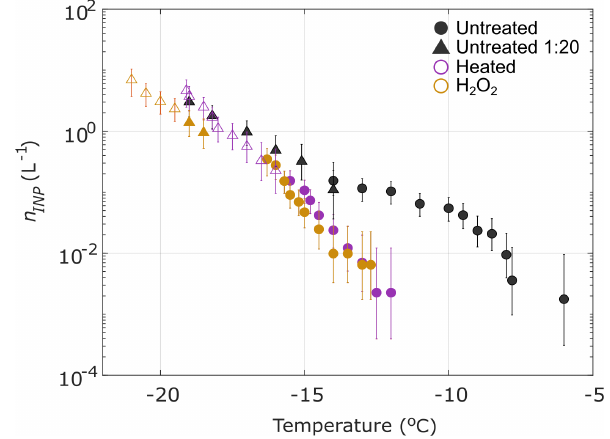
Figure 6. Measured concentrations of INPs in an aerosolized soil dust sample “N12-SD”, collected 50km north of Cairo, Egypt (Nie- mand et al., 2012), that was treated with heat and peroxide to test for INP heat lability and organic composition, same as in Fig. 5 above (Methods Sect. 2.4). A 1 : 20 dilution of the sample is shown (tri- angles), and markers of heat-treated and peroxide-treated samples are filled to indicate significant INP concentration differences from untreated samples according to Fisher’s exact test ( p< 0 . 05). Sen- sitivity to peroxide and heat treatments indicates biological INPs between − 6 and − 16 ◦